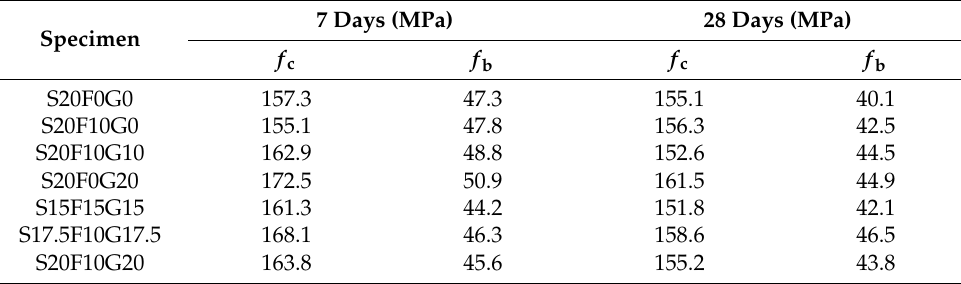
Table 4. Mechanical properties of EUHPC under steam